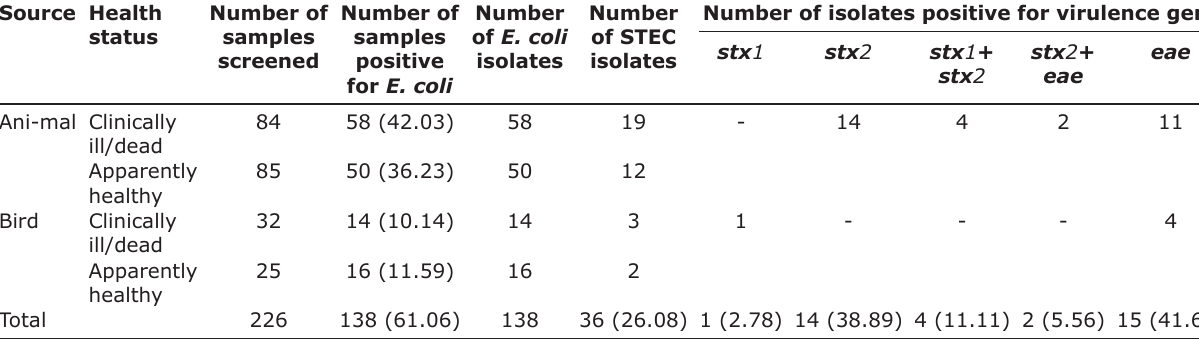
Figures in the parenthesis indicate percentages. STEC=Shiga toxigenic Escherichia coli , stx : Shiga toxin